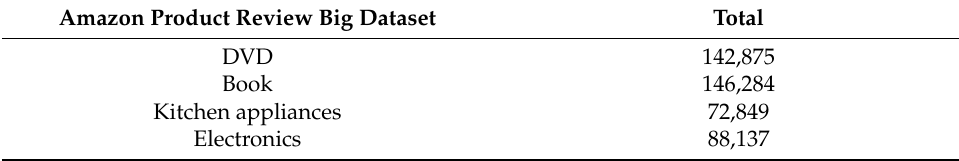
Table 1. Count of Records in